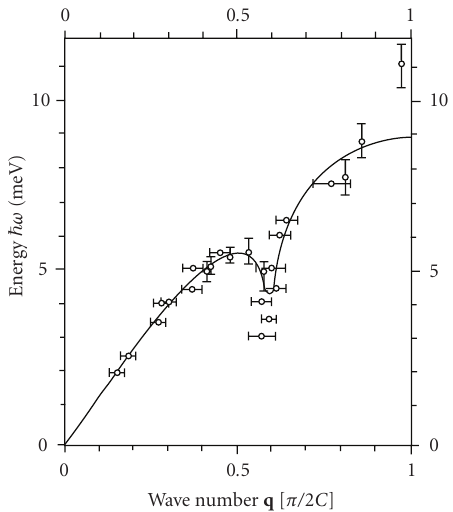
Figure 1: Longitudinal acoustic phonon branch of K 2 Pt(CN) 4 Br 0 . 30 ◦ 3D 2 O in the [001] direction at room temperature. Solid line represents the result of a calculation based on the simple free-electron model as discussed in